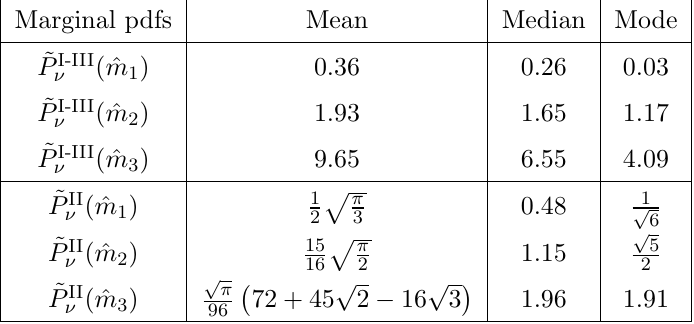
Table 3 . Location parameters for the marginal singular value pdfs of (cid:12)gure